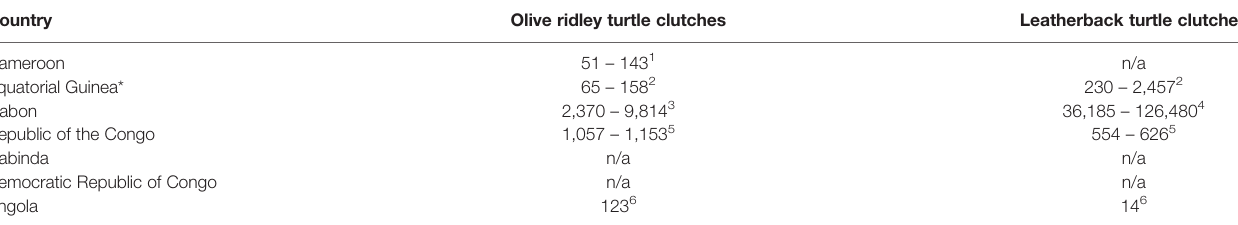
TABLE 1 | Estimated number of olive ridley and leatherback turtle clutches laid annually at nesting beaches along the Atlantic coast of Central Africa. Country Olive ridley turtle